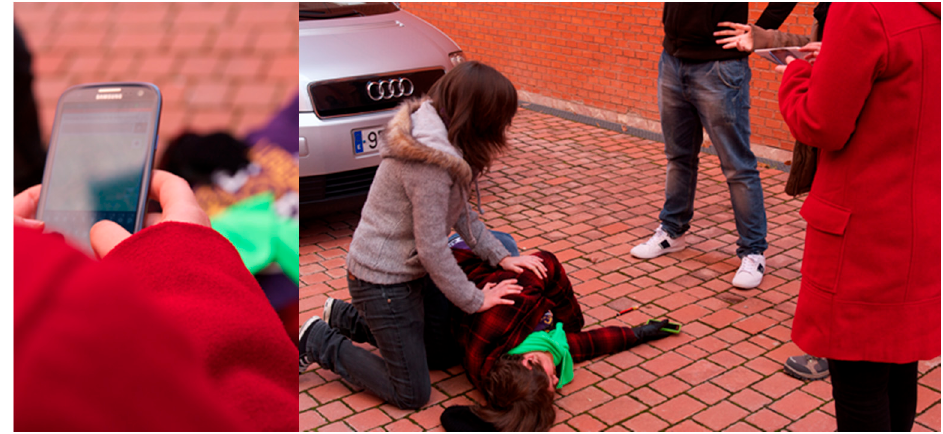
Figure 3. The simulated car accident in a university campus.